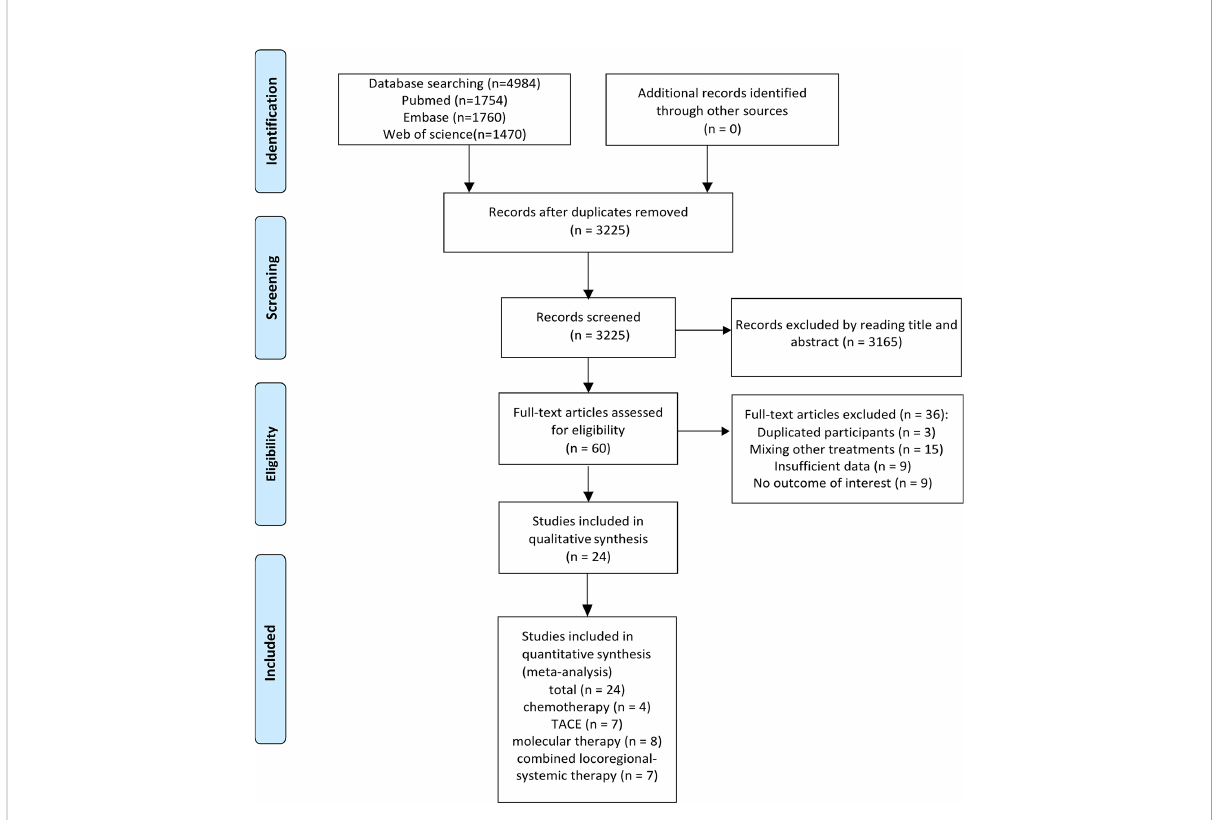
FIGURE 1 The fl owchart for the study search and